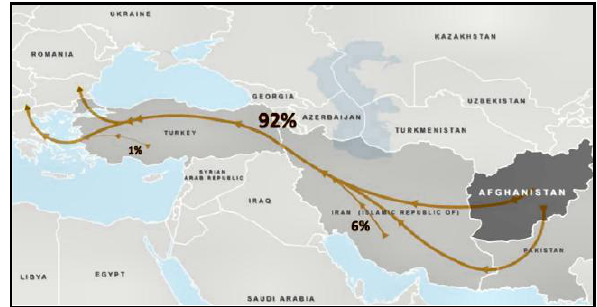
Figure 2: Survey of migrant flow monitoring – results for Afghanistan migrants (IOM 2016).